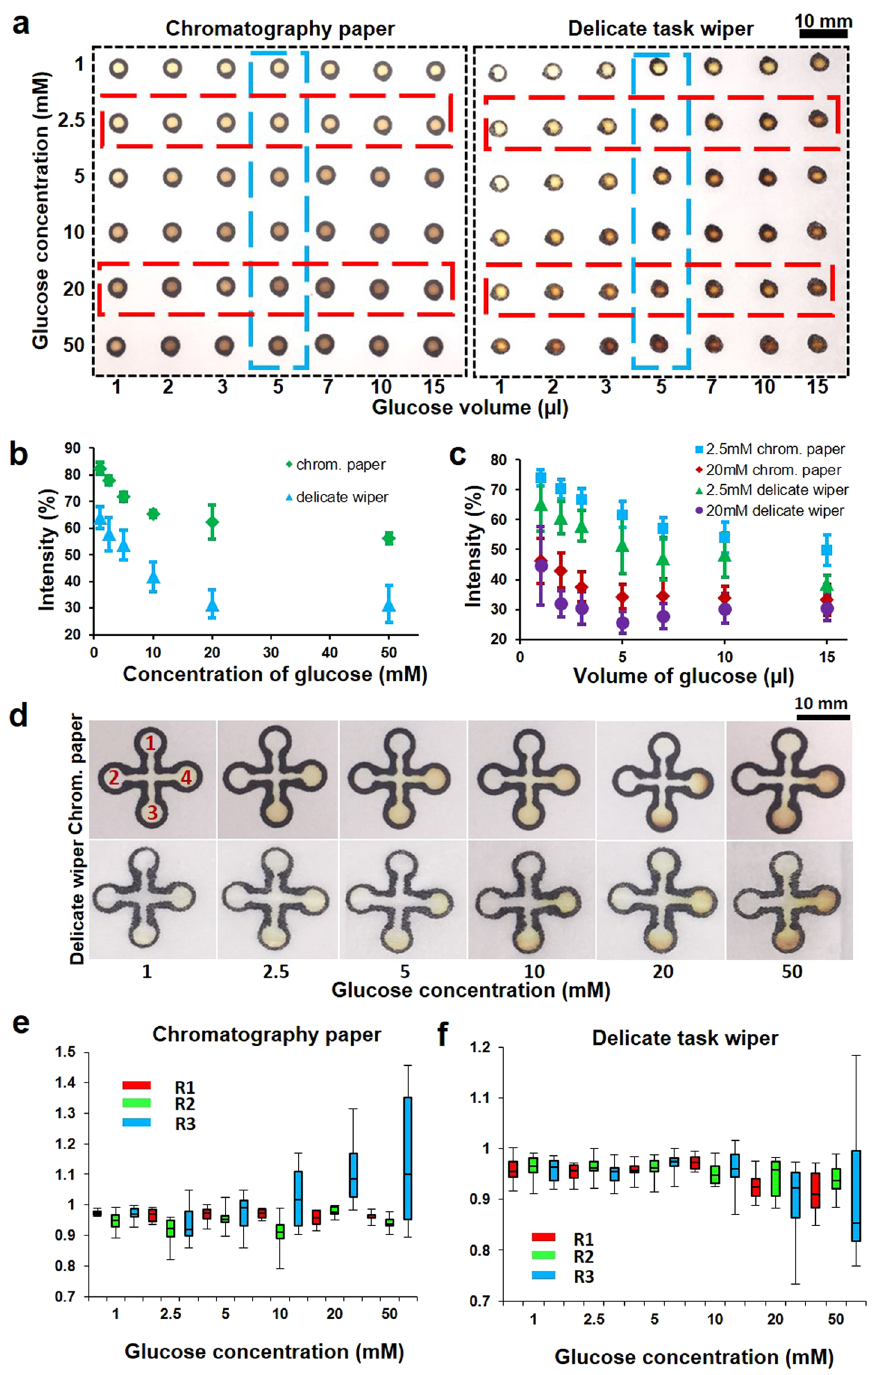
Figure 5. Glucose assay via calorimetric method. ( a ) Effect of glucose concentration and volume on color intensity. ( b ) The quantified results of the effect of glucose concentration on color intensities at constant volumes of 5 µ l and 2 µ l for chromatography paper and delicate task wipers, respectively. ( c ) The quantified results of the effect of glucose volume on color intensities at concentrations of 2.5 mM and 20 mM on